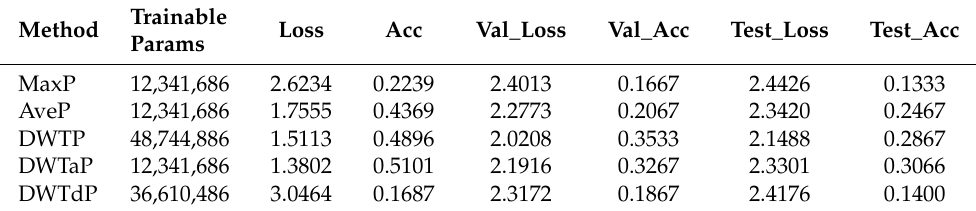
Table 6. Performance of pooling methods on FMD—SGD optimizer.